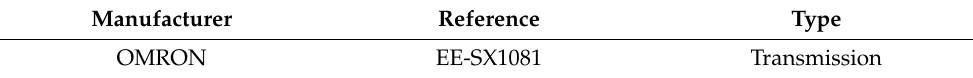
Table 1. Optical sensor characteristics.